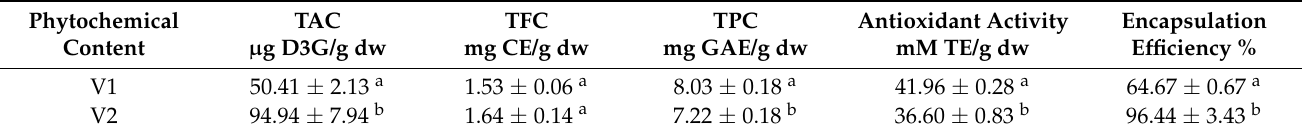
Table 2. Characterization of the encapsulated eggplant peels